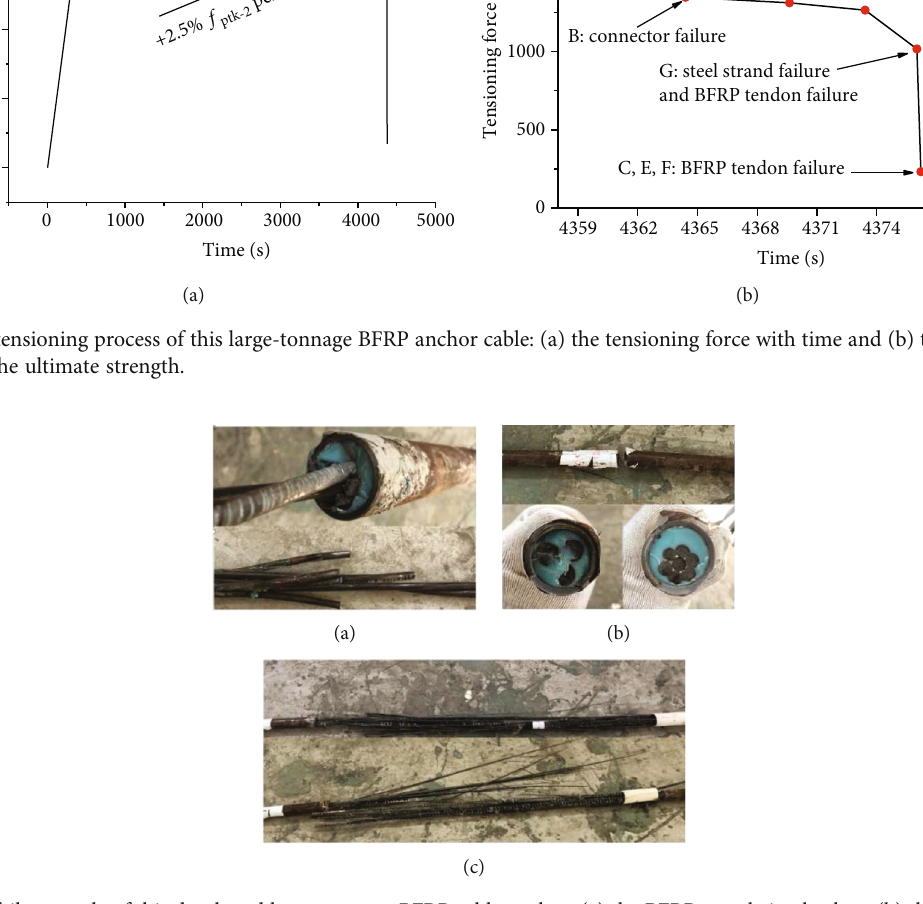
Figure 13: The failure mode of this developed large-tonnage BFRP cable anchor: (a) the BFRP rope being broken, (b) the steel strand being broken, and (c) the middle connector being broken.